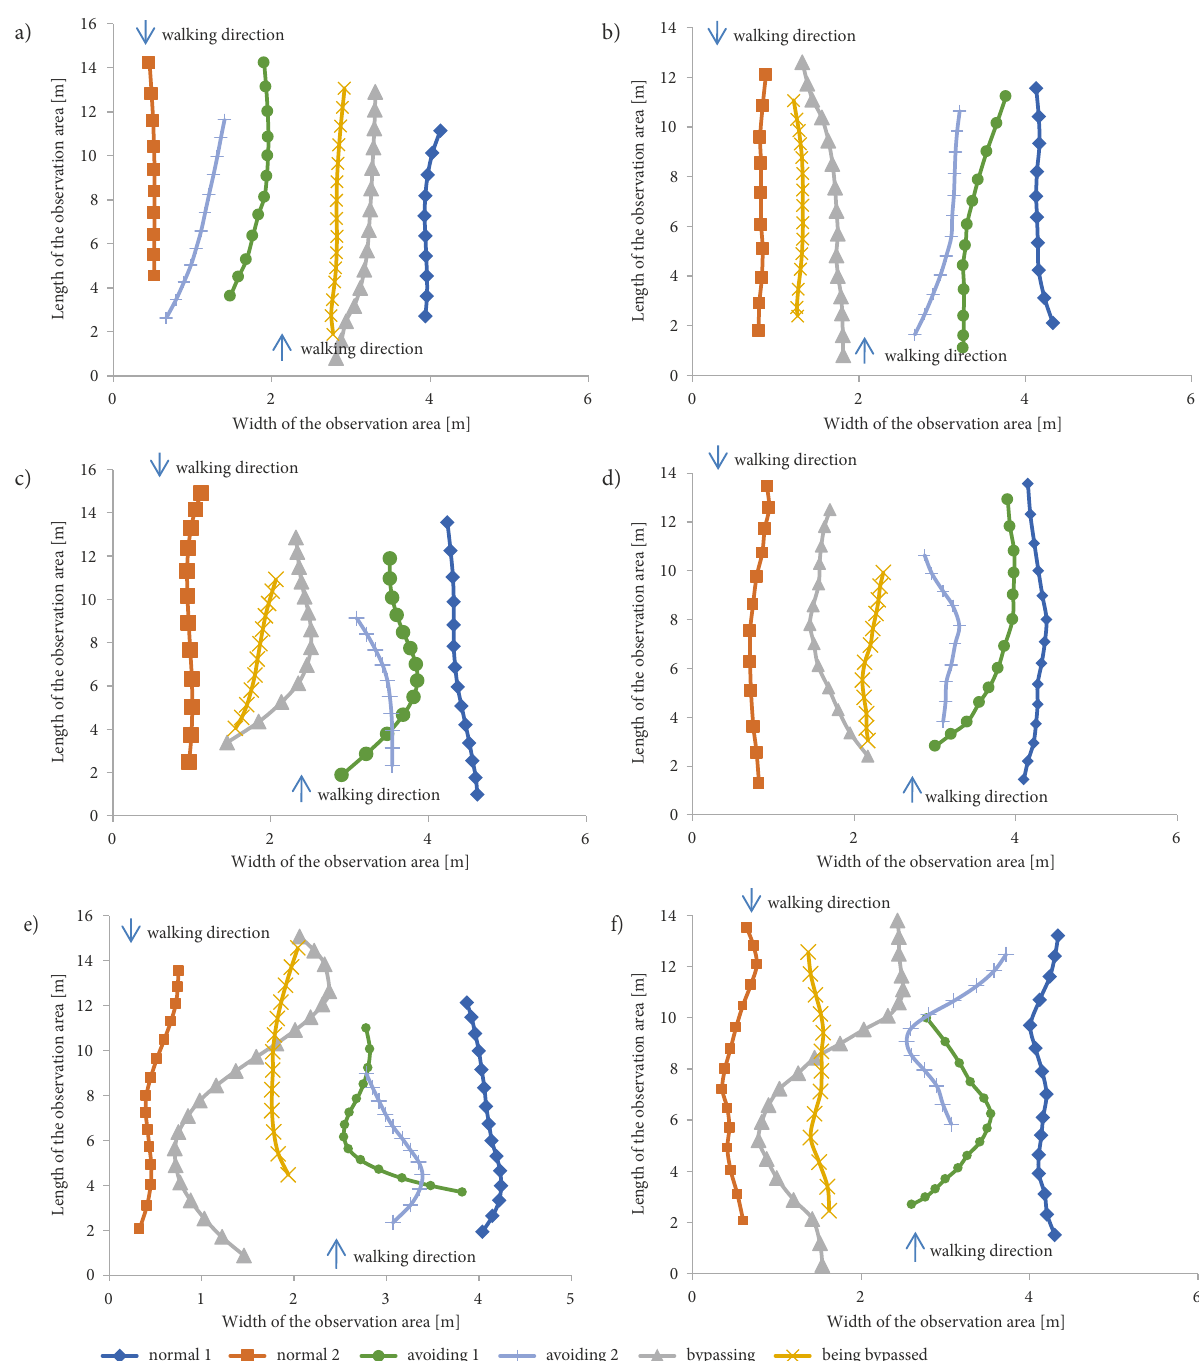
Figure 2. Typical behaviour trajectories under different levels of the pedestrian flow rate: a – at level B of the pedestrian flow rate in Jingsong Subway Station; b – at level B of the pedestrian flow rate in Xidan Commercial Area; c – at level C of the pedestrian flow rate in Jingsong Subway Station; d – at level C of the pedestrian flow rate in Xidan Commercial Area; e – at level D of the pedestrian flow rate in Jingsong Subway Station; f – at level D of the pedestrian flow rate in Xidan Commercial